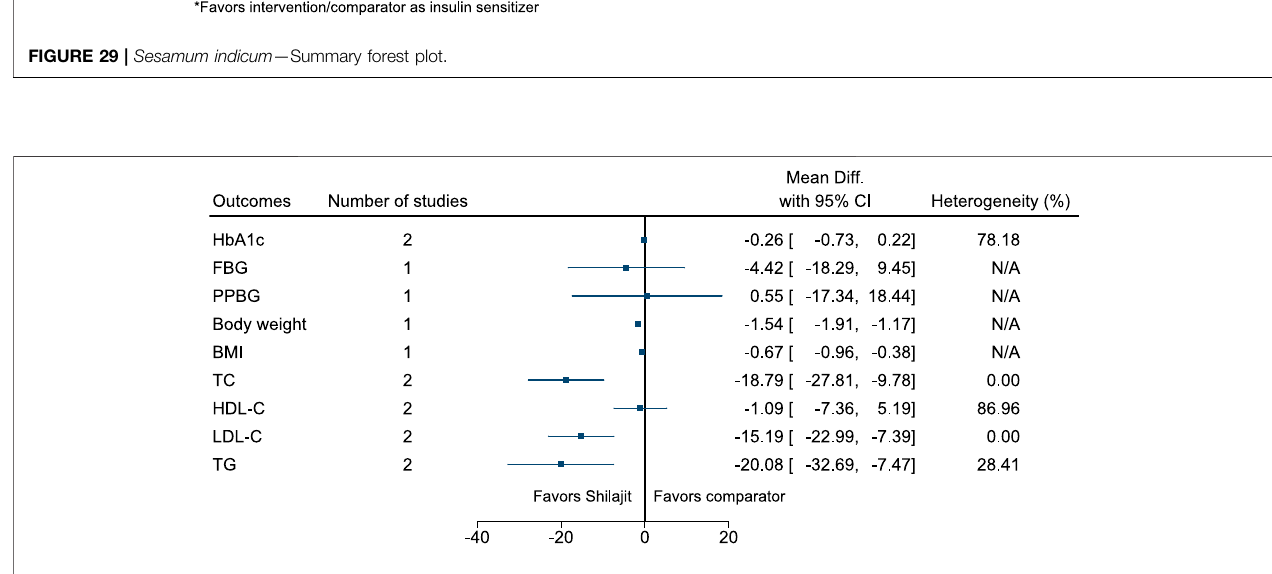
FIGURE 30 | Shilajit — Summary forest plot.